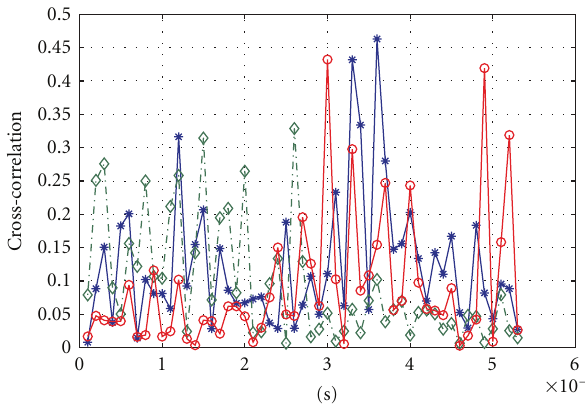
Figure 9: Histogram plot of estimated elevation angles using ESPRIT algorithm when mutual coupling is uncompensated.